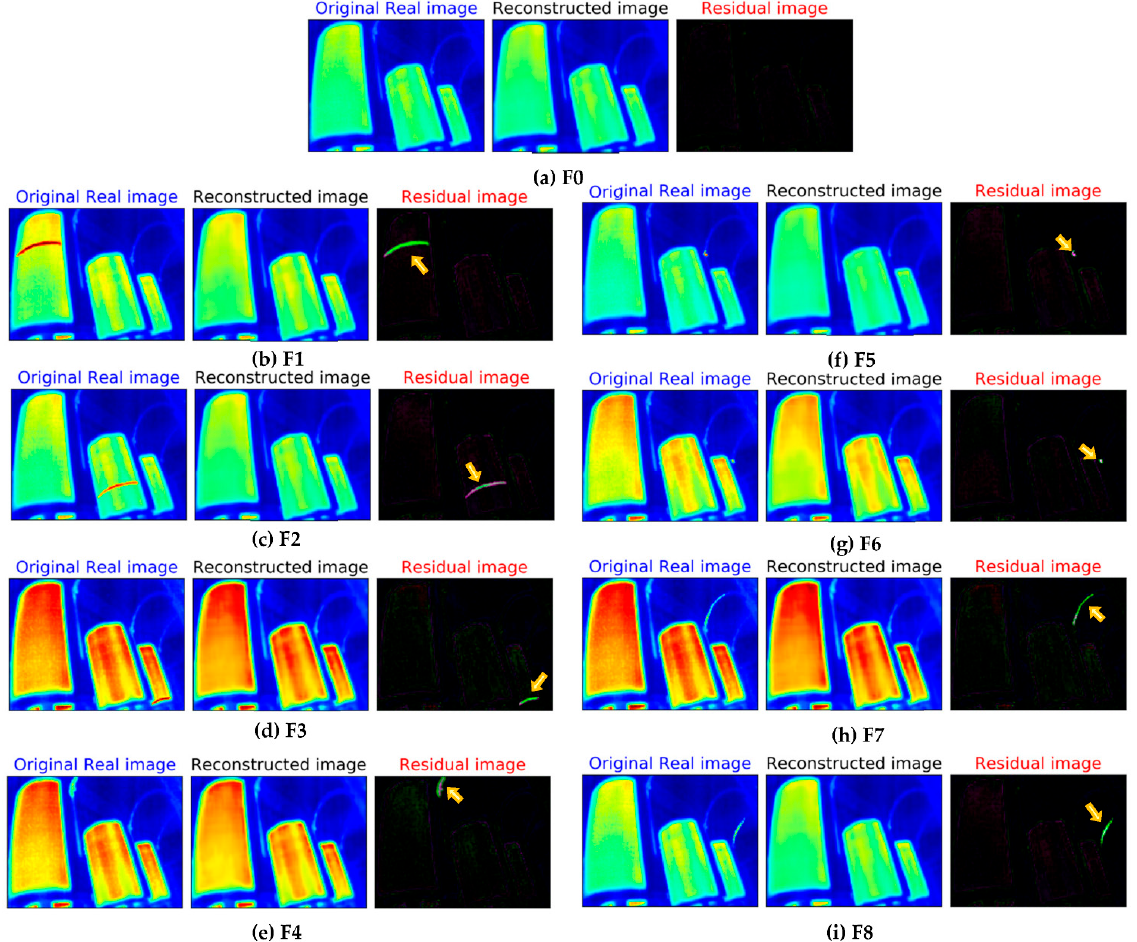
Figure 7. The real, reconstructed and differential IRT images under the different conditions. ( a ) The normal case (F0). ( b – d ) The interturn short circuit in phase R, S and T (F1–F3). ( e – g ) The connection overheating in phase R, S and T (F4–F6). ( h , i ) The wire overheating in phase S and T (F7–F8). (Yellow arrow shows the position of fault under different conditions).